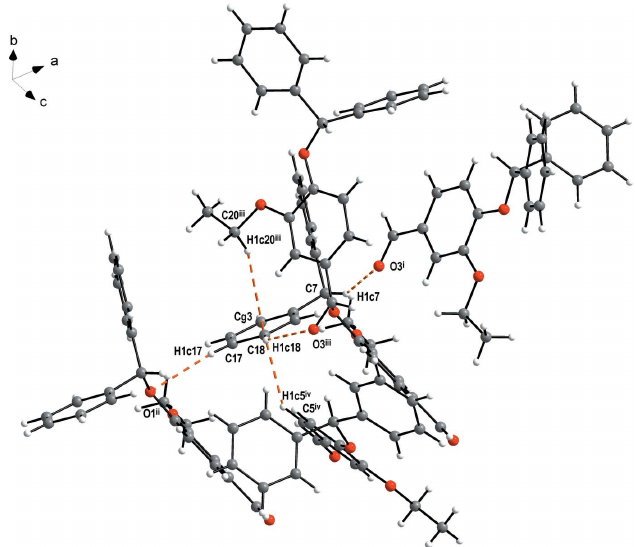
Figure 2 Partial packing diagram showing the hydrogen bonds in the title compound. Hydrogen atoms not involved in hydrogen bonding were omitted for clarity. Symmetry codes: (i) (cid:4) x + 1, y + 1 z ; (iii) (cid:4) x + 1 , y + 1 , z 2 2